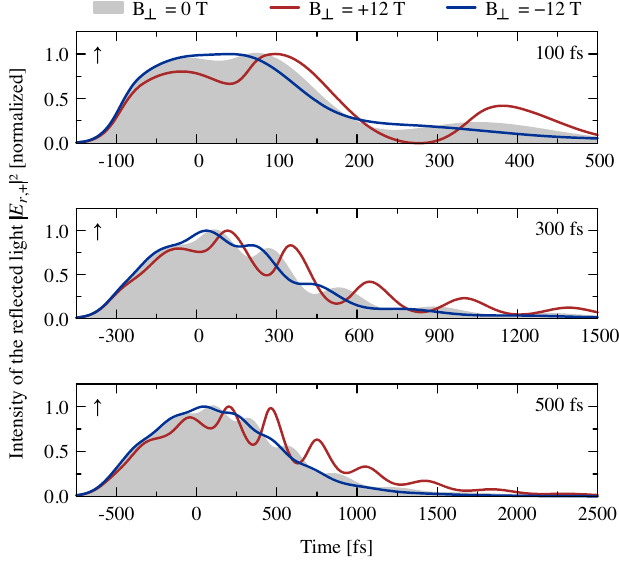
FIG. 7. Normalized time-dependent intensity of the reflected t Þj 2 for a monolayer of MoS 2 at 5 K for different light j E r; þ ð magnetic fields B ⊥ . The intensity FWHM of the different linearly ( ↑ ) polarized pulses with fixed pulse area Θ ¼ 2 π is indicated, ϵ − g μ and the laser pump energy ℏ ω B ⊥ = 2 is varied along p ¼ x B with B ⊥ to always ensure resonant excitation of the exciton transition P þ